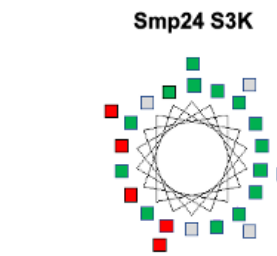
Figure 4. Helical wheel analysis of Smp24, Smp24 K7F and Smp24 S3K. Charged residues are red and hydrophobic non-polar residues are green.